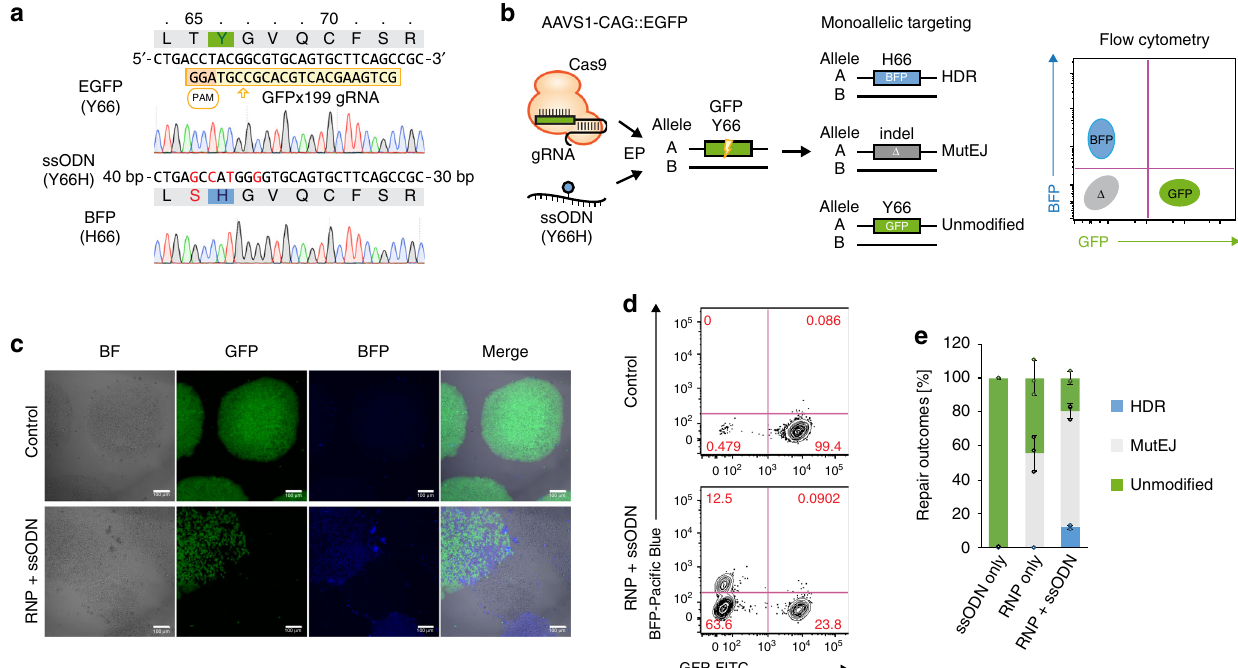
Fig. 1 Visualization and quanti fi cation of DNA repair outcomes in a fl uorescent DNA repair assay in human iPS cells. a Sequence of the GFP reporter target site and engineered modi fi cation to BFP. The sequence of gRNA GFPx199 is boxed in yellow, the PAM sequence in orange, the GFP fl uorophore residue p.Y66 in green and BFP fl uorophore residue p.H66 in blue. Nucleotide changes are indicated in red in the ssODN sequence and in the resulting BFP sequence product. b Schematic of the predicted outcomes from GFP editing in a heterozygous AAVS1-CAG::EGFP (GFP) iPS cell line, and their distribution in FACS. c Confocal microscopy images of the unedited heterozygous GFP iPS cell line (Control), and fl uorescent conversion outcomes following co- transfection of Cas9 RNP and Y66H ssODN repair template (RNP + ssODN). Scalebars are 100 µ m. Representative images of three independent experiments with similar results are shown. d Representative FACS plots of unedited GFP iPS cells (top) and cells treated with Cas9 RNP and Y66H ssODN (bottom). e Quanti fi cation of HDR, MutEJ or unmodi fi ed DNA repair outcomes by FACS analysis. Data are presented as the mean ± S.D. of three